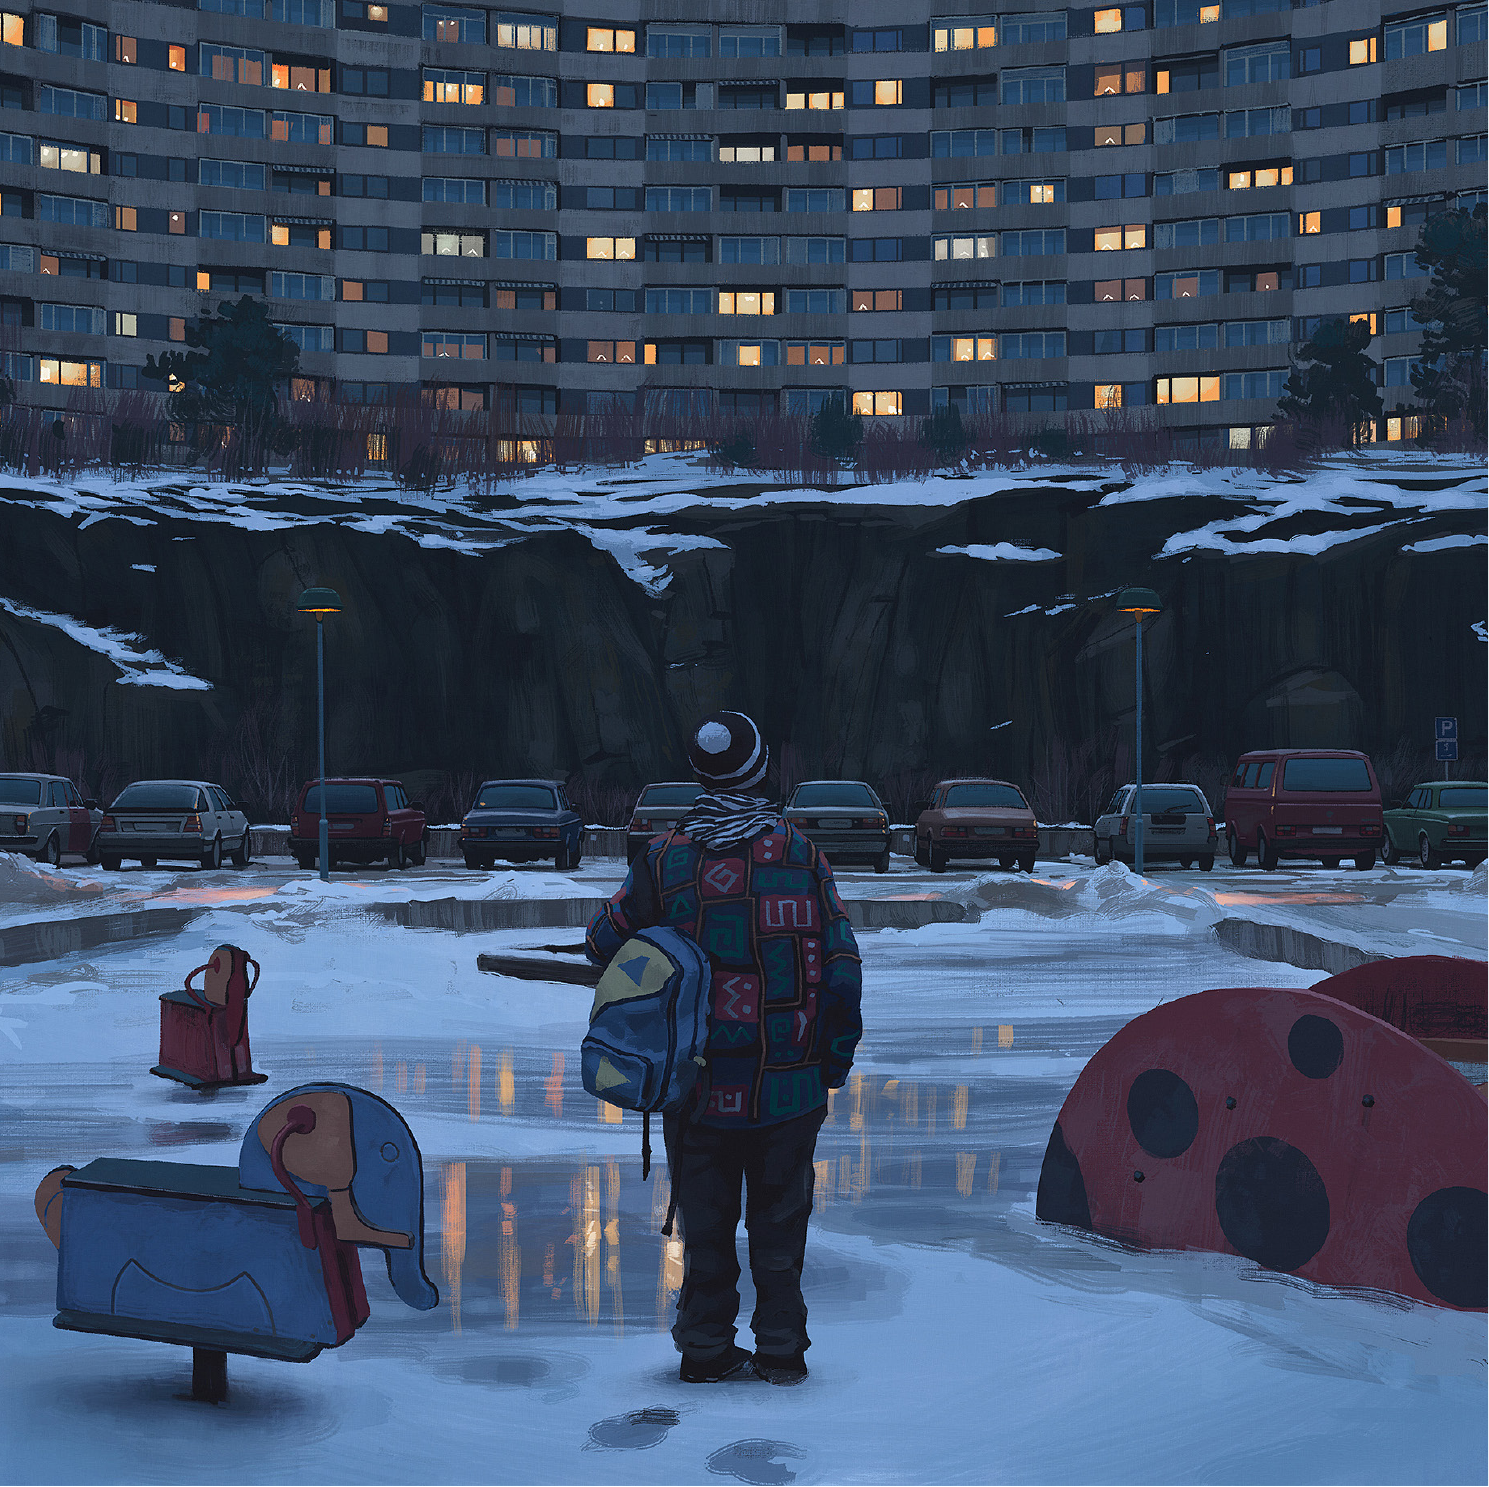
FIG. “The apartment was at the bottom of the Hägerstalund’s Diving Tower, one of the twelve vertical cities in Mälardalen. They were built between 1965 and 1970 ad a part of a major public housing program, and Hägerstalund alone consisted of about 1,500 aprtments. The ground level held a subway station, library, school, daycare, and shops. The tower was crowned with the characteristic water tower.” Simon Stålenhag, Things from the Loop , pp. 16-17, 2015 © 2016 Simon Stålenhag